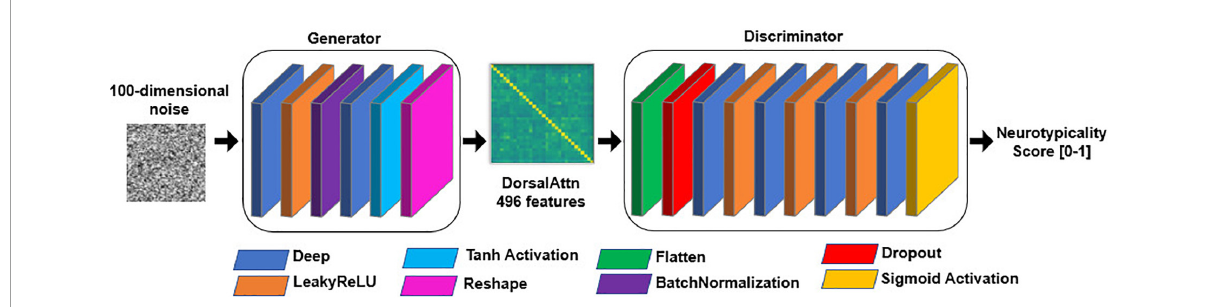
FIGURE2 General structure of generative adversarial network (GAN) models. Each layer is only fed forward, represented by the color-coded rectangles. The discriminator subnetwork is fed with batches of both generated (i.e., fake) data from the generator as well as genuine training data. rely on 100-length random noise